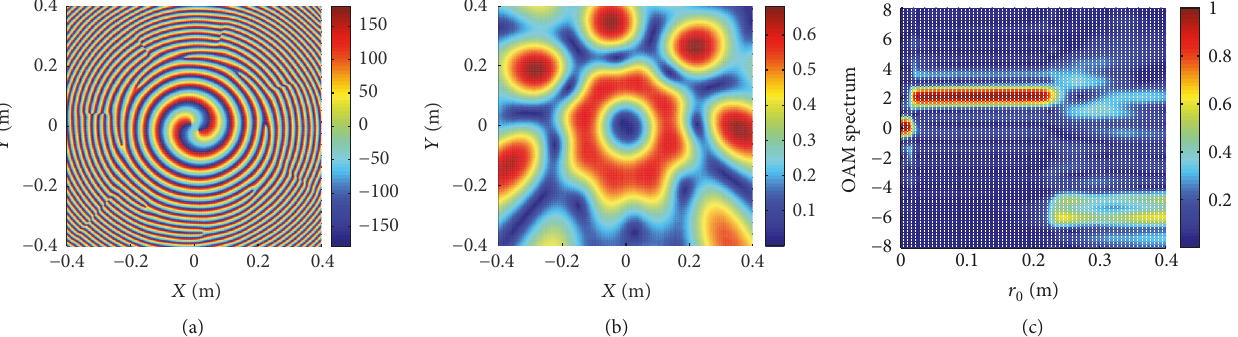
Figure 4: (a) Phase profile, (b) intensity pattern, and (c) the OAM spectrum after utilizing radio OAM steering at (30 ∘ , 30 ∘ ) .